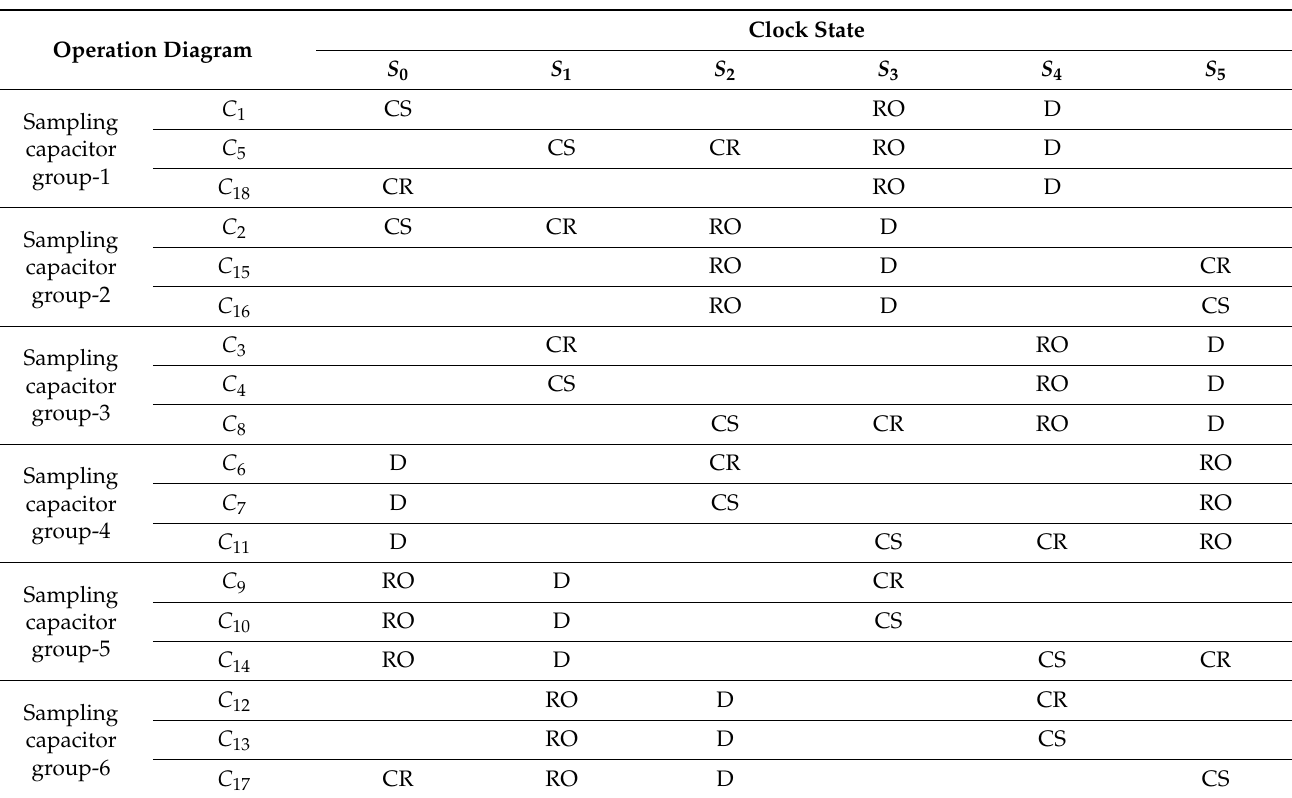
Table 2. Operation diagram of the proposed architecture for the input sample weights of {1,2,1}. CS, CR, RO, and D stand for charge sampling, charge redistribution, read-out, and discharging,